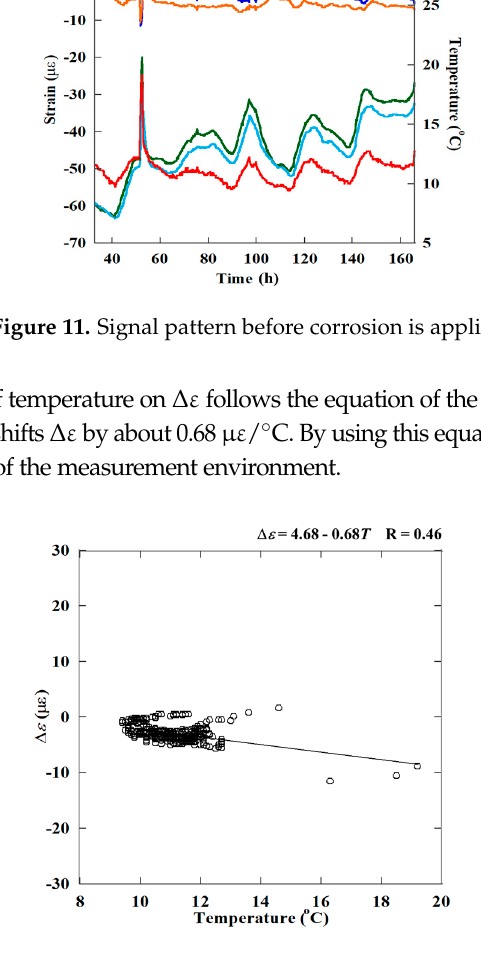
Figure 12. Relationship between the voltage and temperature .